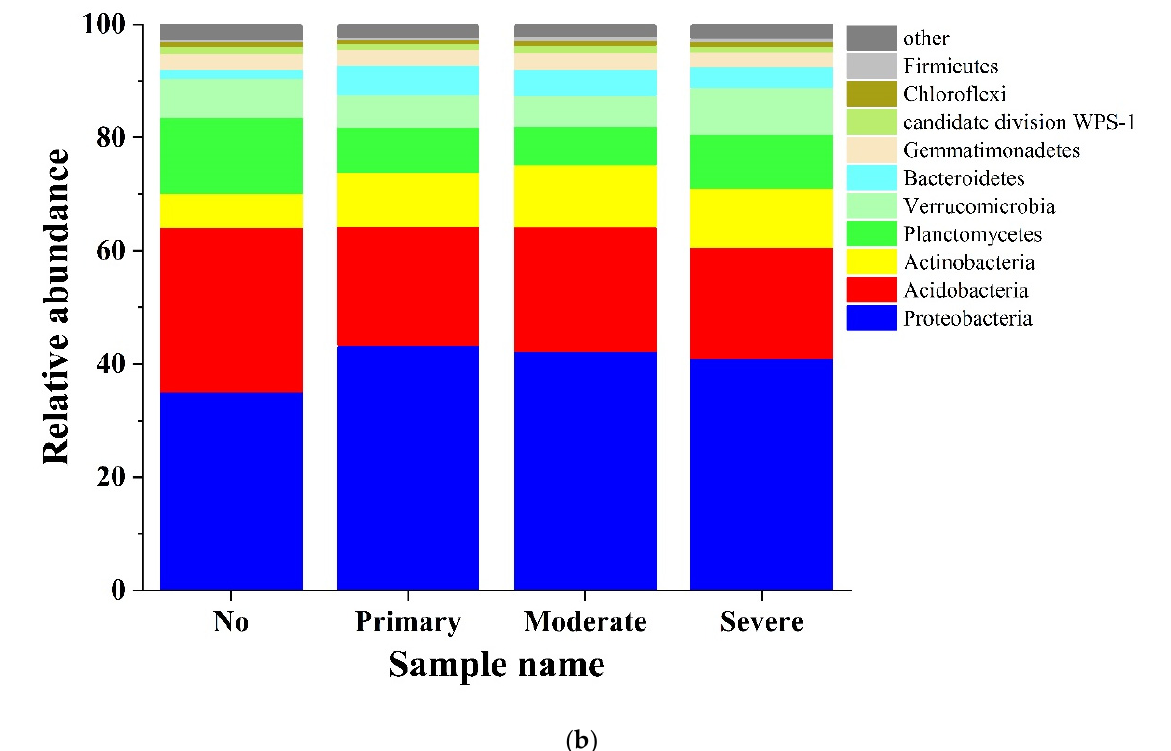
Figure 3. Phylum composition of fungi ( a ) and bacteria ( b ). No, no invasion; primary, primary in- vasion; moderate, moderate invasion; severe, severe invasion.